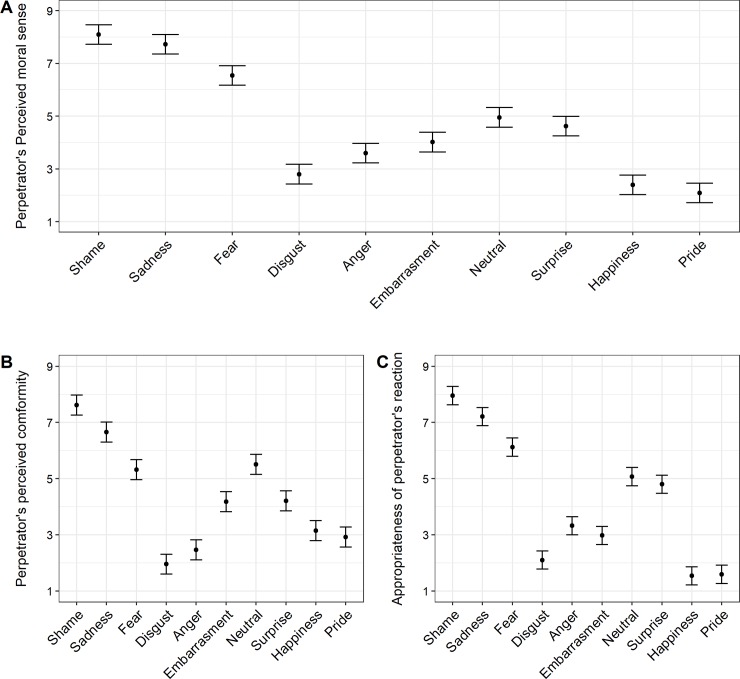
Ratings on perpetrators’ perceived moral sense, conformity, and appropriateness of their reaction.Error bars reflect 95% confidence intervals of the estimated marginal means.